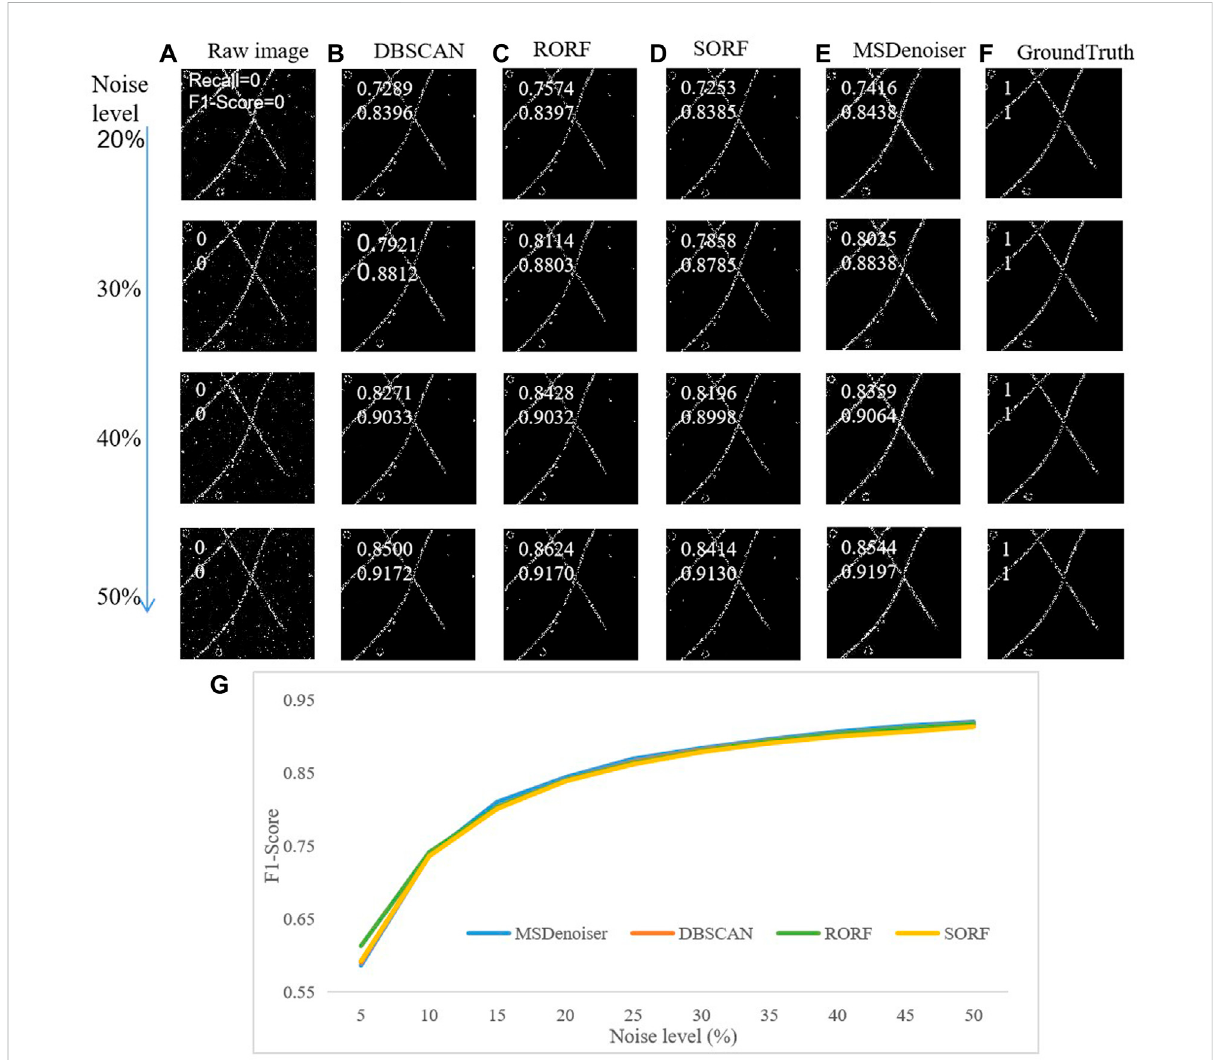
FIGURE 4 Comparison on the denoising performance in simulated microtubule data with different noise levels. (A) Raw rendered image. (B) Denoised image from DBSCAN. (C) Denoised image from RORF. (D) Denoised image from SORF. (E) Denoised image from MSDenoser. (F) Skeleton based groundtruth. (G) The dependence of F1-score on noise